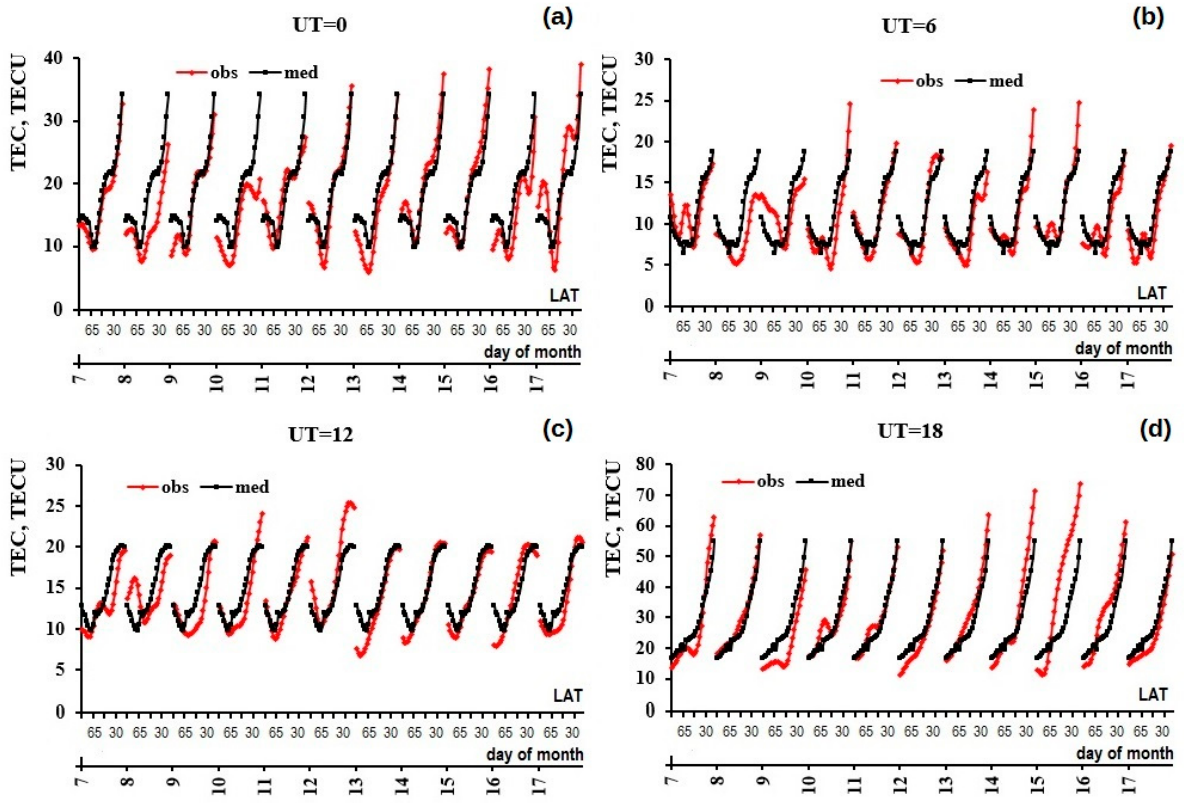
Figure 5. Latitudinal TEC dependences during 7–17 March 2012 for local: ( a ) evening, ( b ) night, ( c ) morning and ( d ) day hours.